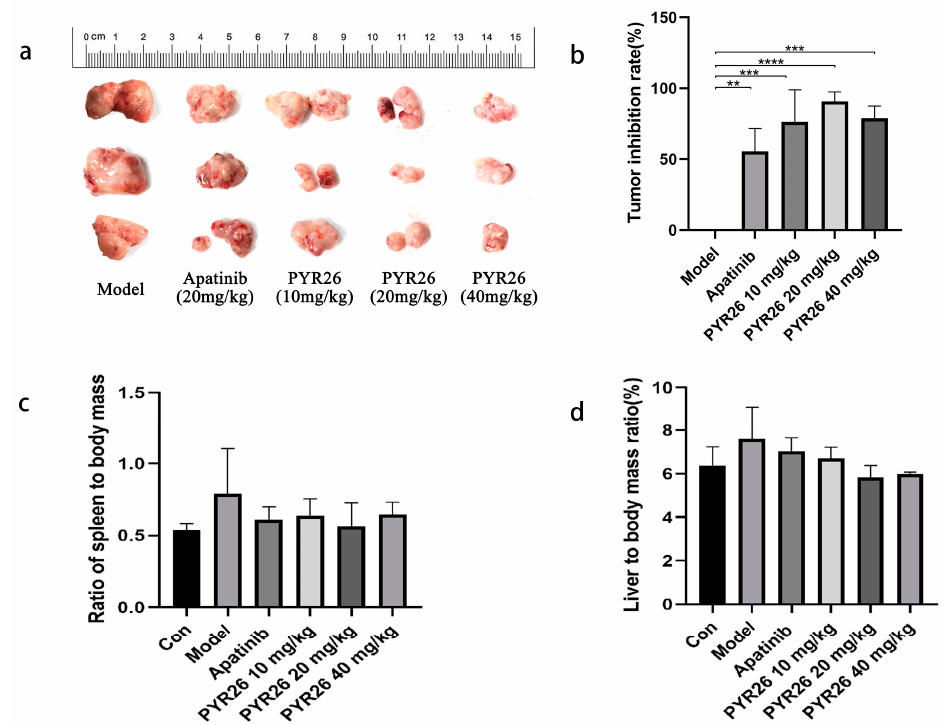
Figure 8. ( a ) Tumors’ size after 14 days of PYR26 administration. ( b ) Tumor suppression rate in mice after 14 days of PYR26 administration. ( c ) Spleen–body ratio of nude mice after 14 days of PYR26 administration. ( d ) Liver–body ratio of nude mice after 14 days of PYR26 administration. (** p < 0.01, *** p < 0.001,**** p < 0.0001 vs. control group)